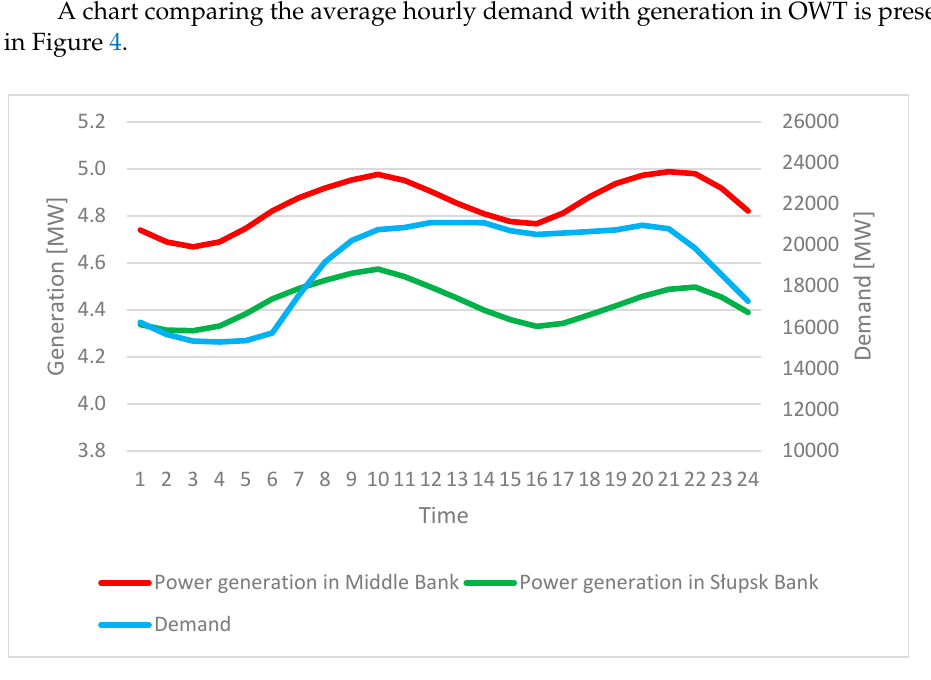
Table 10. Generation in photovoltaic sources and onshore wind sources.